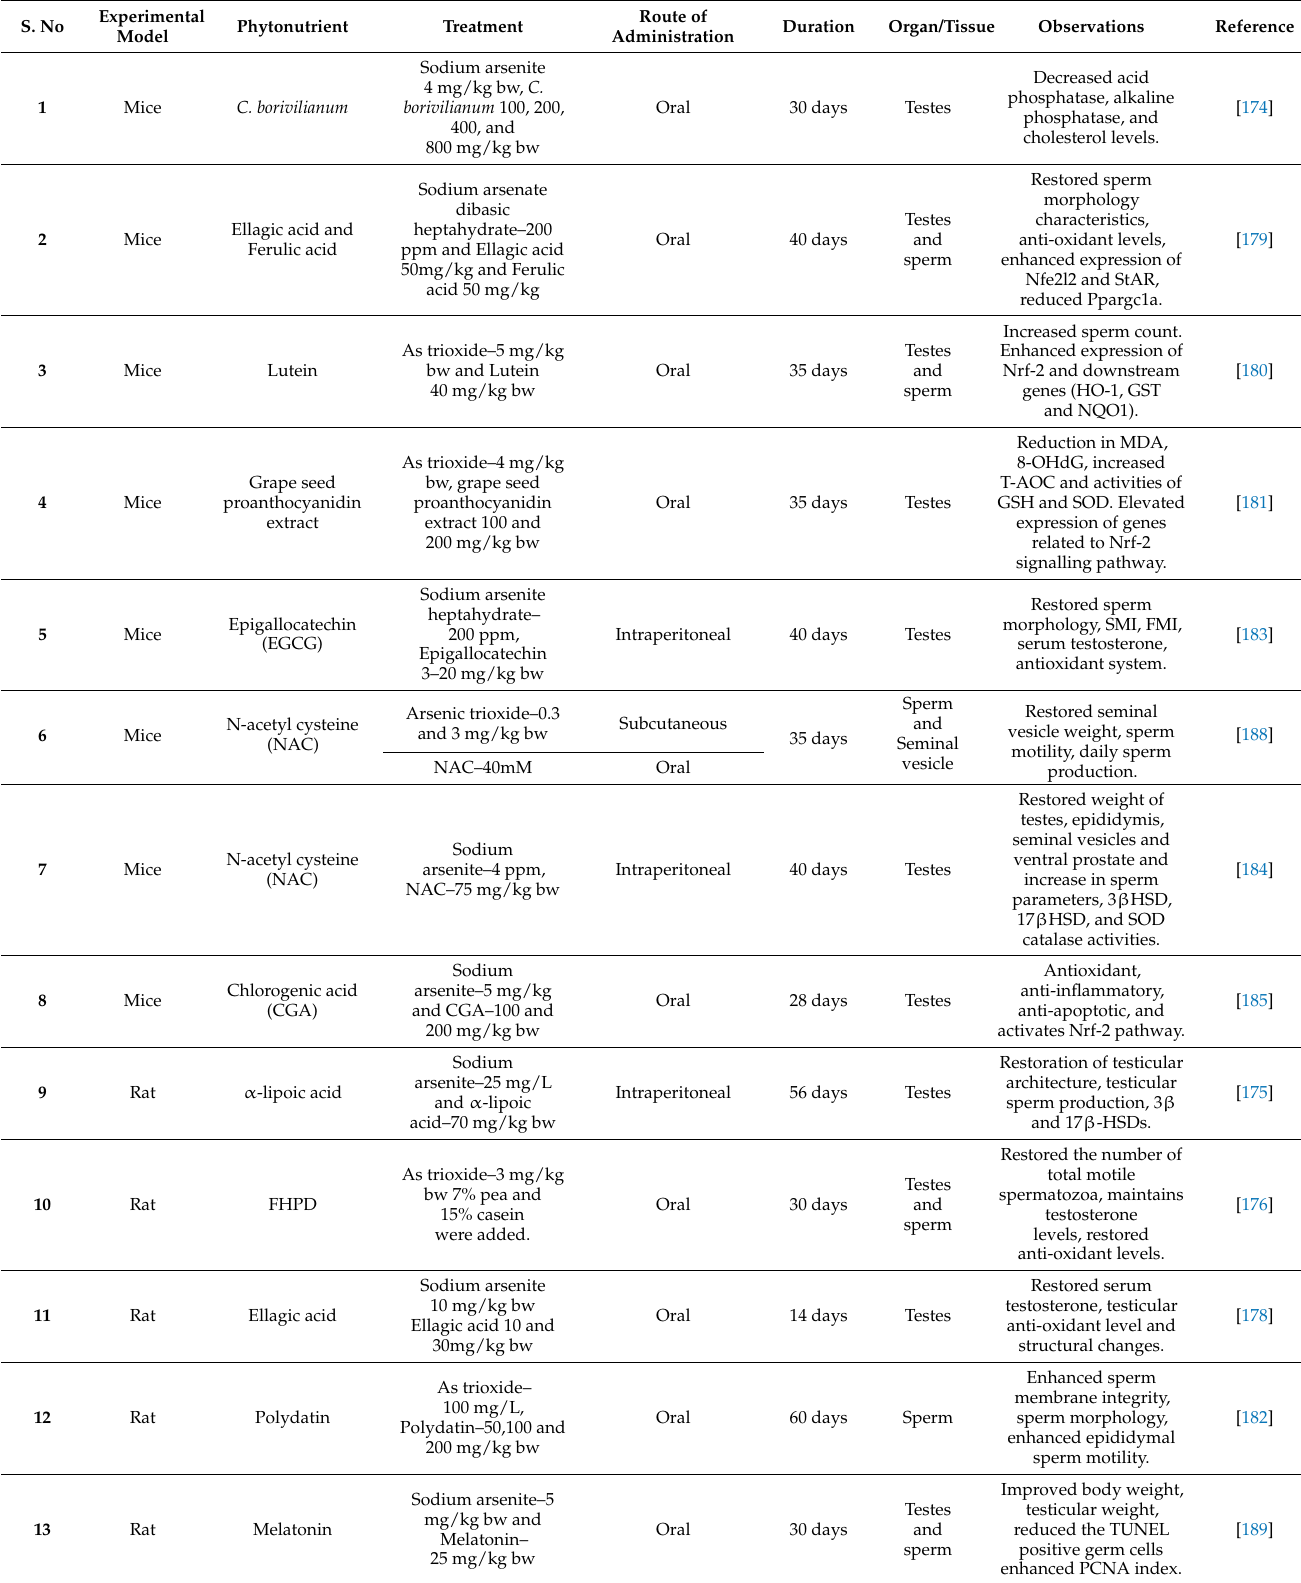
Table 4. The table summarises preclinical findings and interventions for arsenic exposure induced male